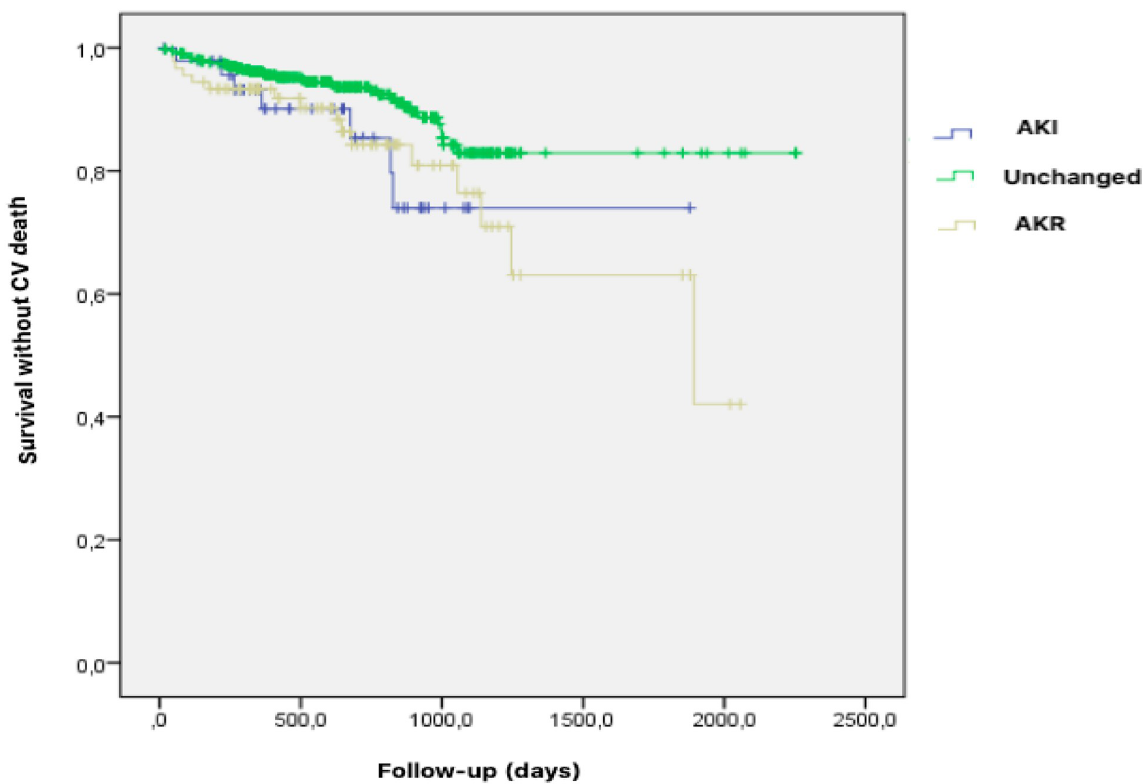
Fig 2. Impact of Acute kidney injury (AKI), Acute kidney recovery (AKR) and unchanged renal function after TAVR on cardiovascular death. Kaplan–Meier analysis for the probability of survival free from cardiovascular (CV) death after TAVR according to renal variations including altered (AKI), unchanged or improved (AKR) renal function. At a median follow-up of 608 days (range 355–893), AKI and AKR patients experienced an increased cardiovascular mortality compared to unchanged renal function patients (14,6% and 17,8% respectively, vs. 8,1%, CI 95%, p < 0.022). Abbreviations : AKI = Acute Kidney Injury. AKR = Acute Kidney Recovery. CV = Cardiovascular. TAVR = Transcatheter Aortic Valve